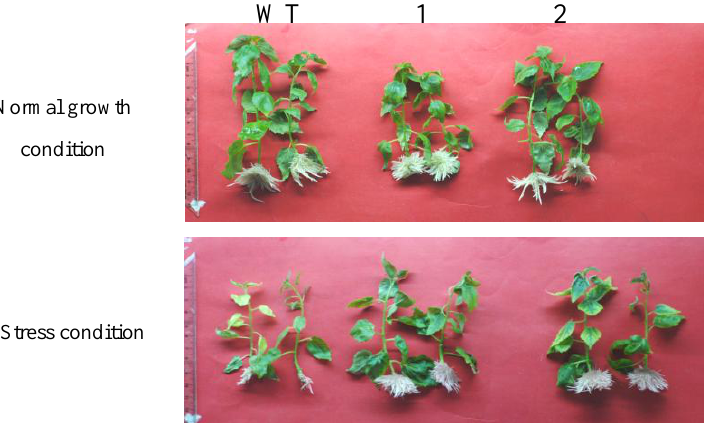
, and 2 stress condition. 2